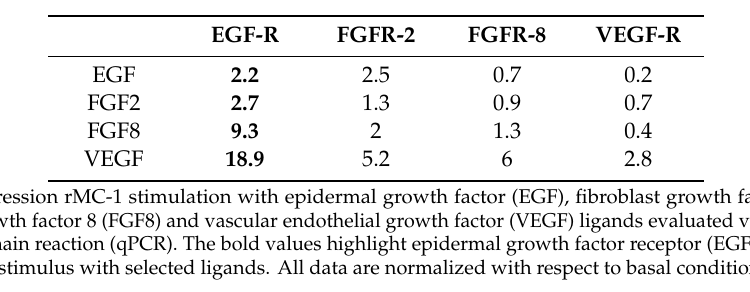
Table 2. Gene expression of cognate receptors in rMC-1 stimulated by a panel of chemotactic ligands.